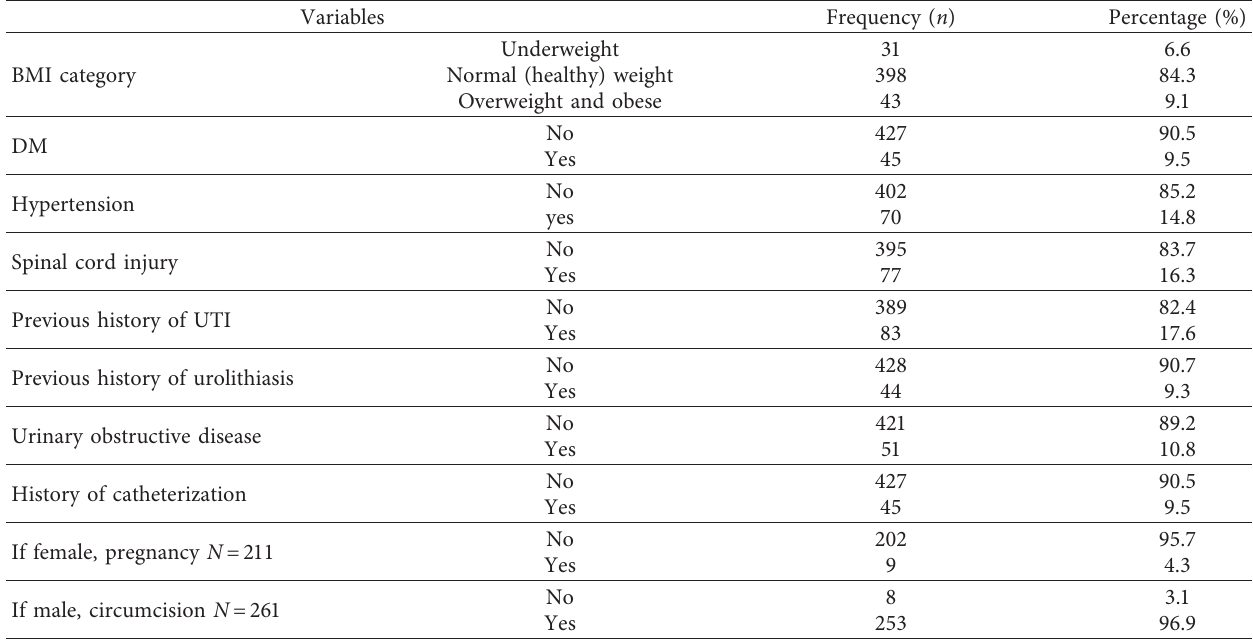
Table 2: Clinical characteristics among adult patients attending the OPD in Tigray region hospitals, Ethiopia, 2019 ( N � 472). Variables Frequency ( n ) Percentage (%) BMI